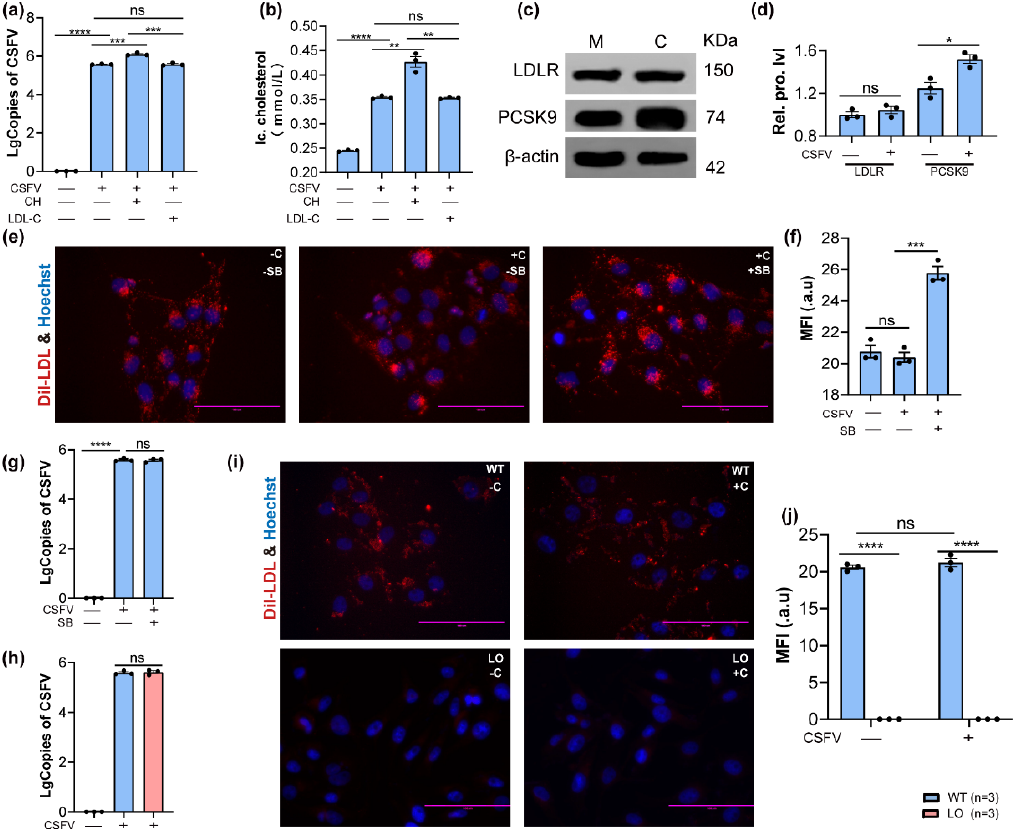
Figure 3. PCSK9 expression and exogenous cholesterol uptake during CSFV infection. ( a ) The viral genome copies of CSFV in PK-15 cells at 48 hpi were detected by qPCR; n = 3; *** p < 0.001;**** p < 0.0001. ( b ) The detection of intracellular cholesterol levels in CSFV-infected PK-15 cells; n = 3; ** p < 0.01; **** p < 0.0001. ( c , d ) The protein-expression levels of LDLR and PCSK9; n = 3; * p < 0.05. ( e , f ) The detection of dil-LDL uptake in CSFV-infected PK-15 cells at 48 hpi; n = 3; ** p < 0.01. ( g ) The inhibition of PCSK9 expression did not affect CSFV replication; n = 3; **** p < 0.0001. ( h ) The disruption of LDLR did not affect CSFV replication; n = 3. ( i , j ) The uptake of dil-LDL was completely blocked by the deletion of LDLR; n = 3. (WT, wild-type; LO, ldlr-ko; M, mock; C, CSFV; Rel. prot. lvl, relative protein level; Ic. cholesterol, intracellular cholesterol level; MFI, mean fluorescent intensity).